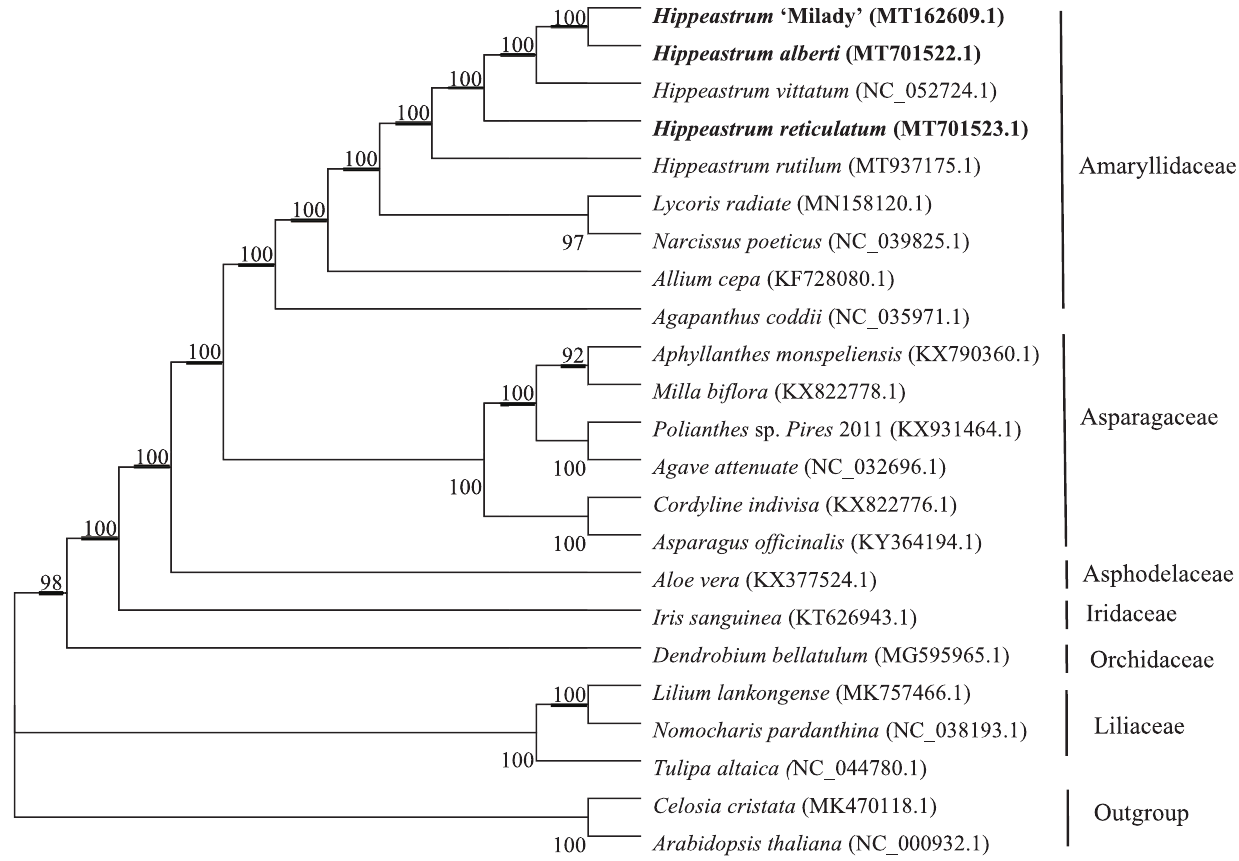
Fig 4. Phylogenetic tree based on maximum likelihood analysis of sequences from whole chloroplast genomes of 18 plant species. Arabidopsis thaliana and Celosia cristata were used as outgroups. Numbers at nodes are bootstrap support